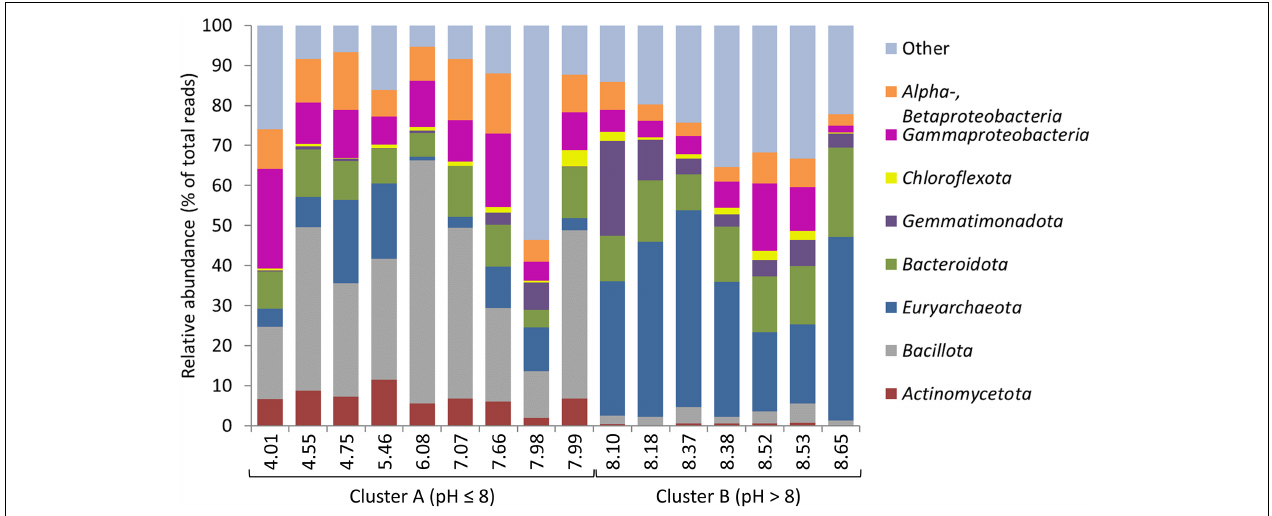
FIGURE 4 | Phylum (and class) level relative abundances within microbial communities from the 16 Western Australian saline lakes sampled in this study. Lakes are arranged in order of ascending pH along the x -axis, and grouped into Clusters (A,B) identified by PERMANOVA.